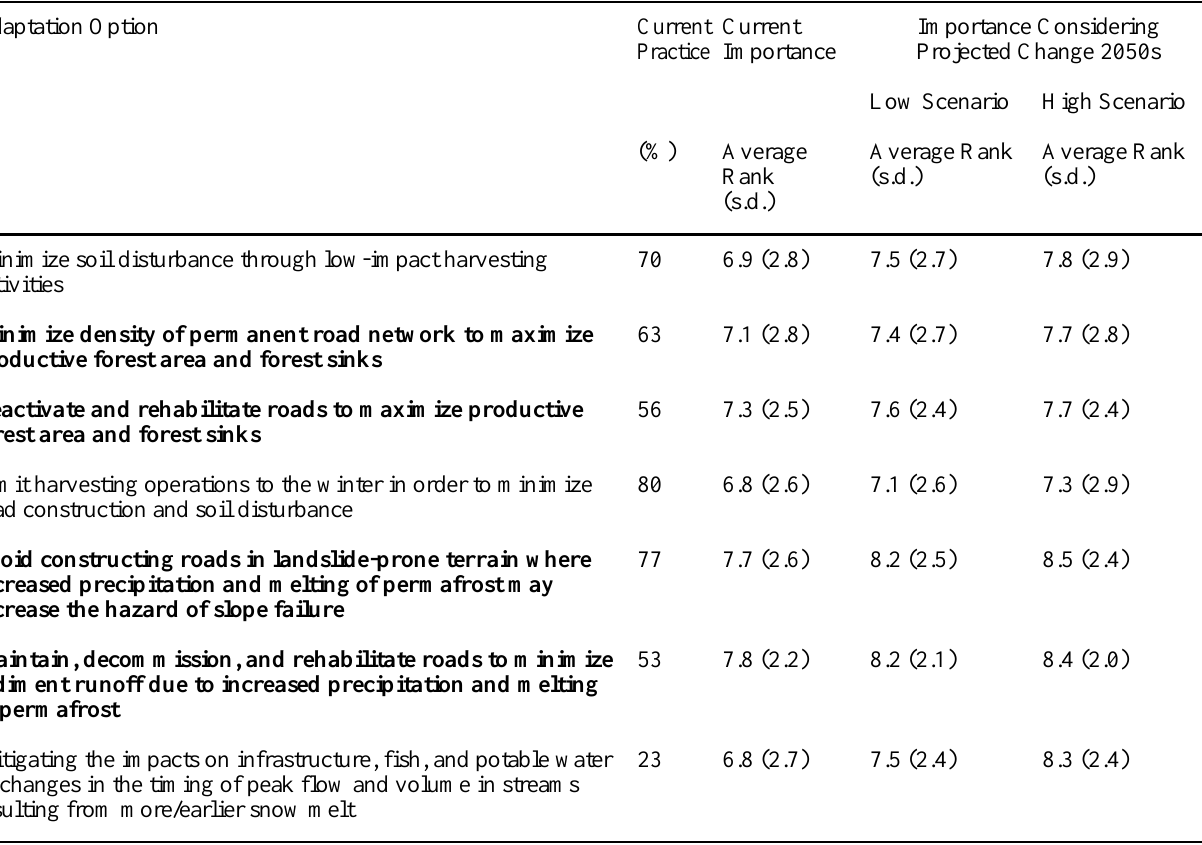
Table 7. Judgments of forest practitioners on the importance of adaptation options to conserve and maintain soil and water resources in forest ecosystems in the Champagne and Aishihik Traditional Territory for each of three scenarios: “current climate conditions,” “low scenario of future climate change by the 2050s,” and “high scenario of future climate change by the 2050s.” Scale of 1 to 10 (0 = no importance, 1 = low importance, 10 = high importance) or don’t know. Results shown are the average rank and standard deviation (s.d.) of participants who provided a ranking. The percentage of participants who agree or strongly agree with the statement “this management option is currently being practiced in the Yukon” is also provided. Adaptation options in bold are considered to be “no-regrets” (option is ranked 7 or higher across range of